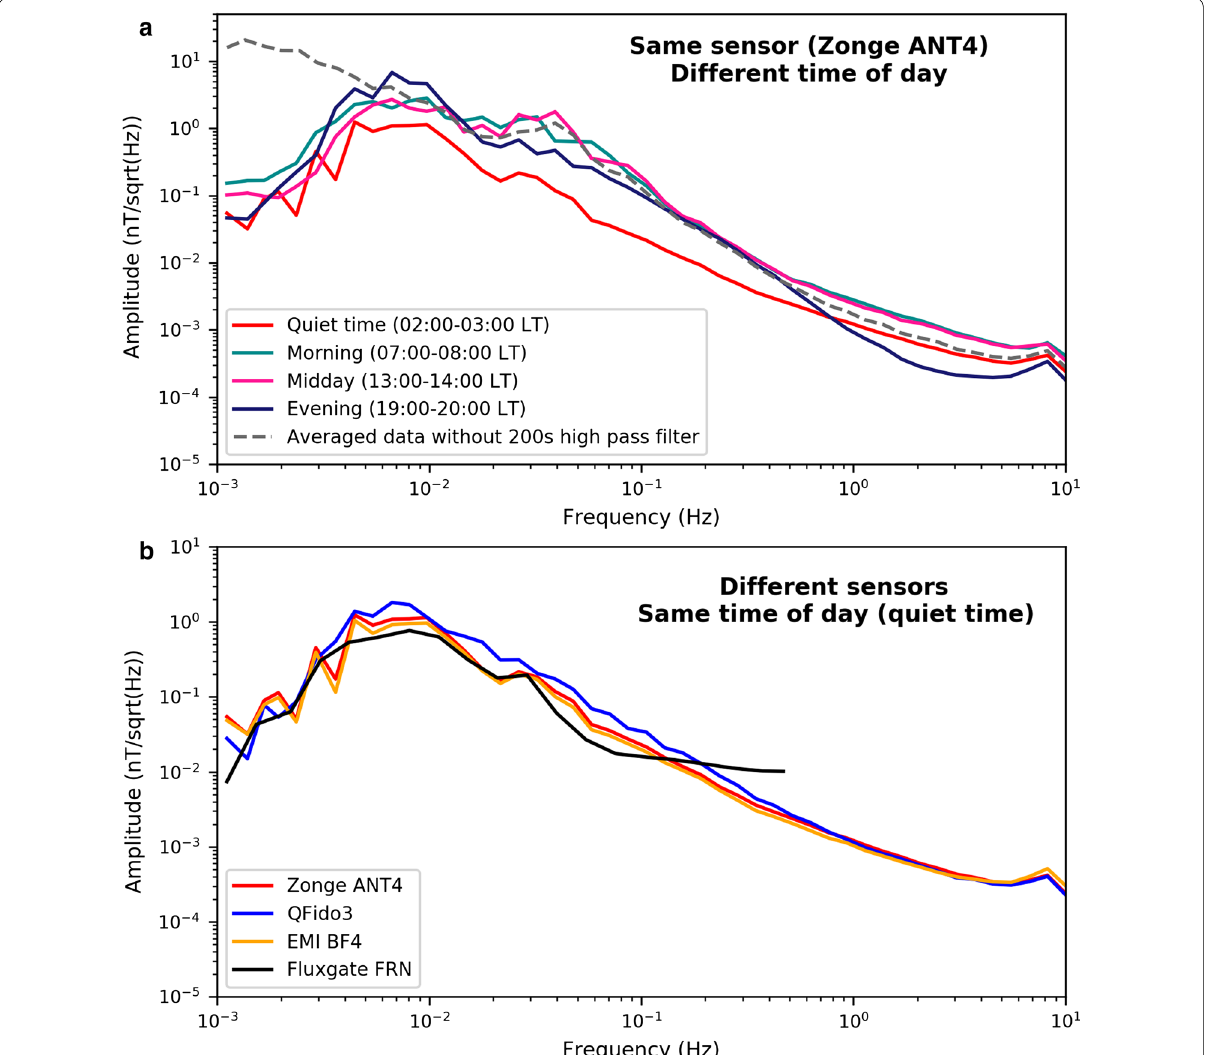
Fig. 6 Comparisons of amplitude spectra between different times of day and between different instruments. a Zonge ANT4 north-oriented coil averaged over 1 h at four different times during April 19, 2014. Solid lines show data filtered from 200 s to 10 Hz. Dashed line is the average spec- trum over the whole day, without a low-pass filter (but still with 10 Hz anti-alias filter). b Amplitude spectra of Zonge ANT4, QFido3, and EMI BF4 coil magnetometers during the “quiet period” (02:00–03:00 local time) on April 19, 2014, also compared with the fluxgate magnetometer at the Fresno (FRN)